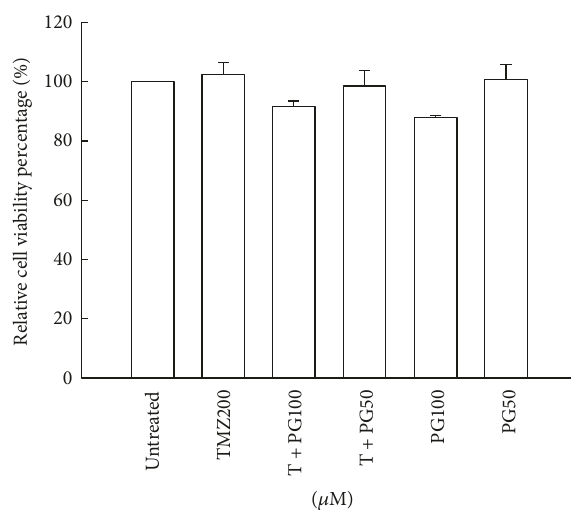
Figure 1: Evaluation of cell viability with TMZ, PG, or TMZ/PG treatment. U87MG cells (1 × 10 4 ) were seeded in each well of a 96-well cultured plate for 24 h and then treated with TMZ (200 μ M), PG (50 or 100 μ M), or their combination for 48h. After treatment, cell viability was determined by an XTT-based assay. The values are represented as mean ± standard deviation ( n = 5 – 8) of individual